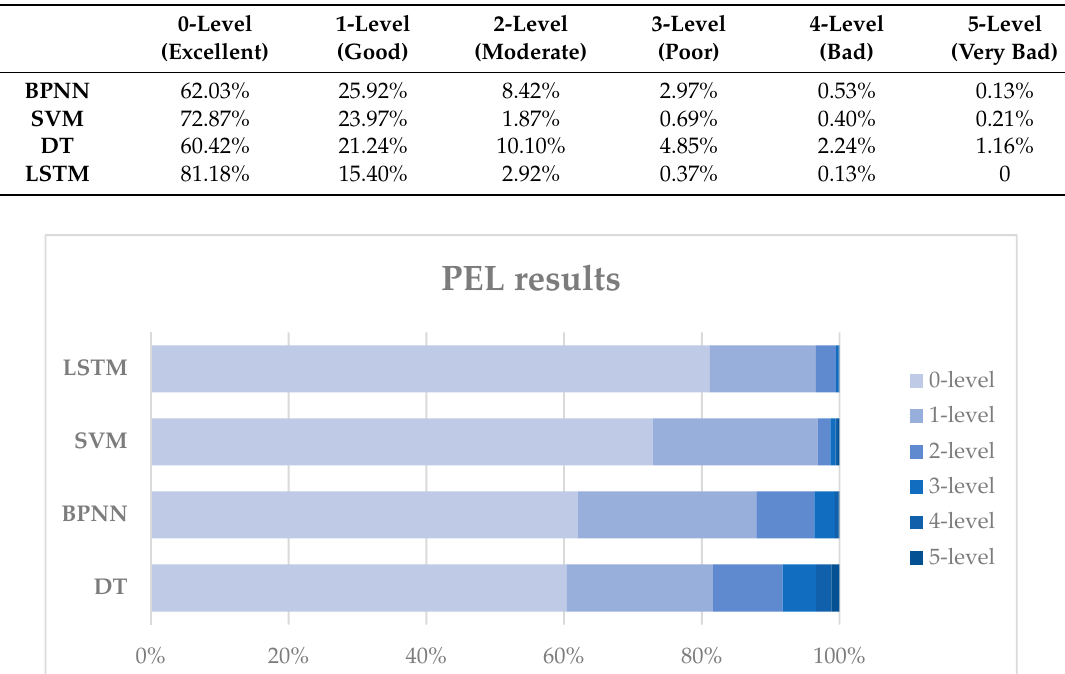
Table 3. PEL results of different models.